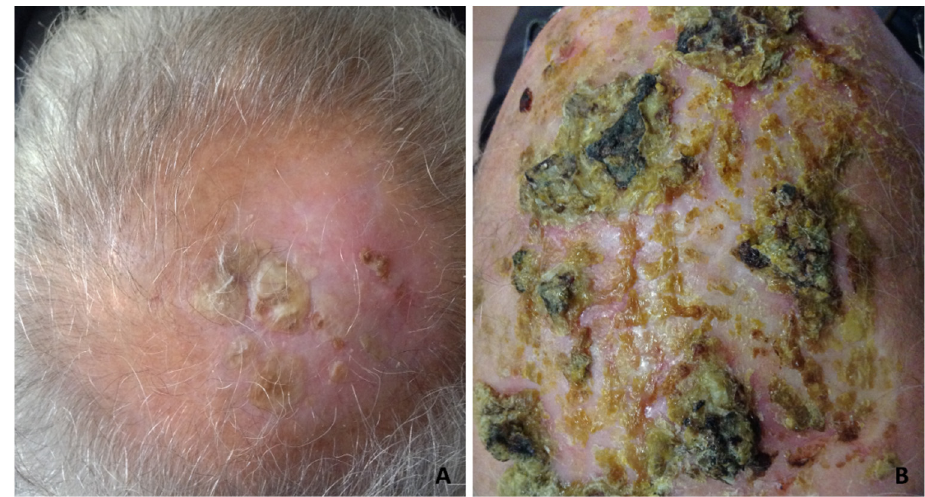
Figure 2. Erosive pustular dermatosis of the scalp; ( A ) thickened keratotic plaques on atrophic skin on the vertex; ( B ) severe clinical presentation with diffuse, thickened, dried yellow crusts, with a greenish or blackish hue resembling pustular pyoderma gangrenosum. Pustules were observed in a minority of cases (Figures 3A, 4A and 5A).